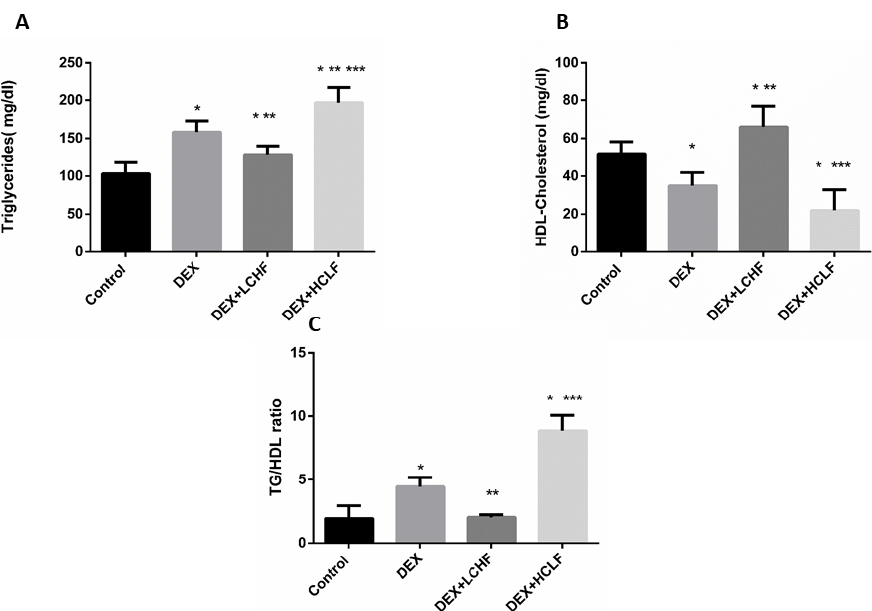
Figure 5. The impact of low-carbohydrate high-fat diet and high-carbohydrate low-fat diet on lipid profile parameters in dexamethasone-treated rats. ( A ): triglycerides; ( B ): HDL-Cholesterol, and ( C ): Triglycerides to HDL-Cholesterol ratio. HDL-Cholesterol: high-density lipoprotein-Cholesterol, DEX, DEX + LCHF, and DEX + HCLF groups. DEX: rats treated with dexamethasone to induce metabolic syndrome; DEX + LCHF: rats treated with dexamethasone to induce metabolic syndrome and fed on low-carbohydrate high-fat diet; DEX + HCLF: rats treated with dexamethasone to induce metabolic syndrome and fed on high-carbohydrate low-fat diet. Statistically significant if p ≤ 0.05. *: Statistically significant compared to the Control group. **: Statistically significant compared to DEX group. ***: Statistically significant compared to DEX + LCHF group.